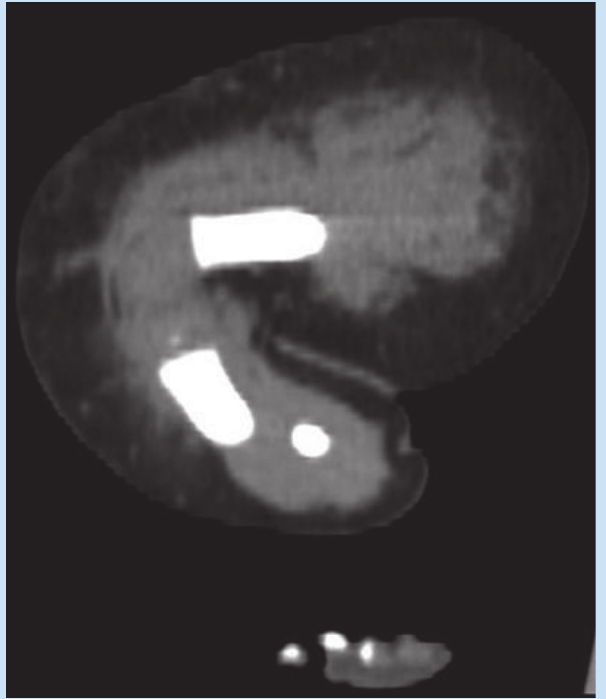
Fig. 2. Sagittal axial CT showing the fatty interdigitation into poorly margin- ated bulky musculature.